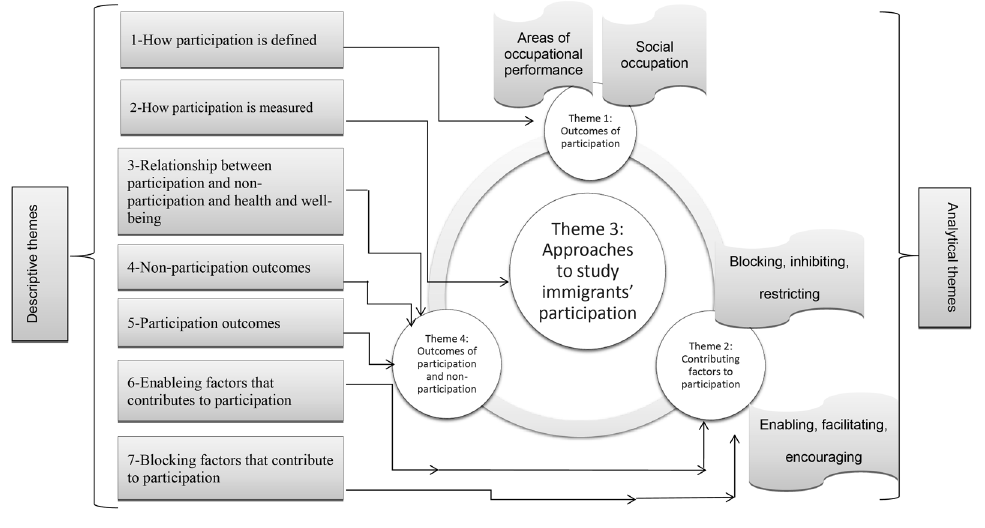
Figure 2. Relationship Between Descriptive and Analytical